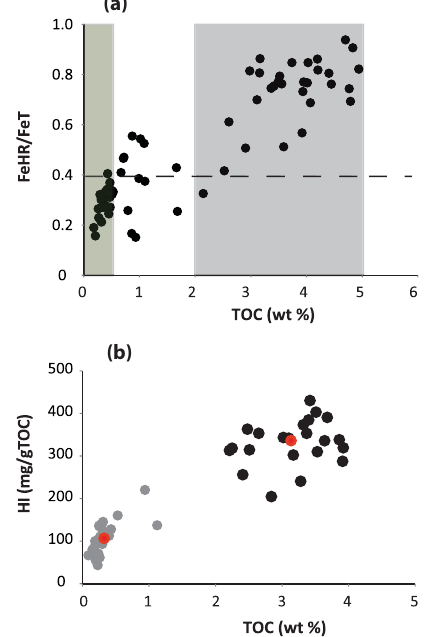
Figure 3. (a) TOC vs. the ratio of highly reactive to total iron (FeHR / FeT) from fresh core material in unit 1 of the Xiamaling Formation. The horizontal dashed line represents a FeHR / FeT of 0.38. The range of TOC values for green-gray shales from outcrop samples is shown in the green rectangular field, while the range in values for the black shales from outcrop is shown in the gray field. (b) TOC vs. HI for outcrop material, with black and green- gray shales separately indicated. The red dots mark the averages for the black and green-gray shale